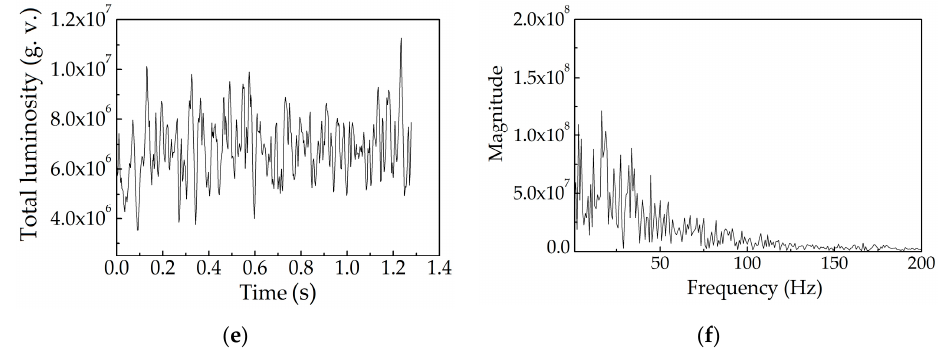
Figure 9. Time curve and corresponding spectrum of total luminosity for fuel mass flow rate: ( a ) time curve at ṁ F = 8 g/min; ( b ) spectrum at ṁ F = 8 g/min; ( c ) time curve at ṁ F = 10 g/min; ( d ) spectrum at ṁ F = 10 g/min; ( e ) time curve at ṁ F = 12 g/min; ( f ) spectrum at ṁ F = 12 g/min.